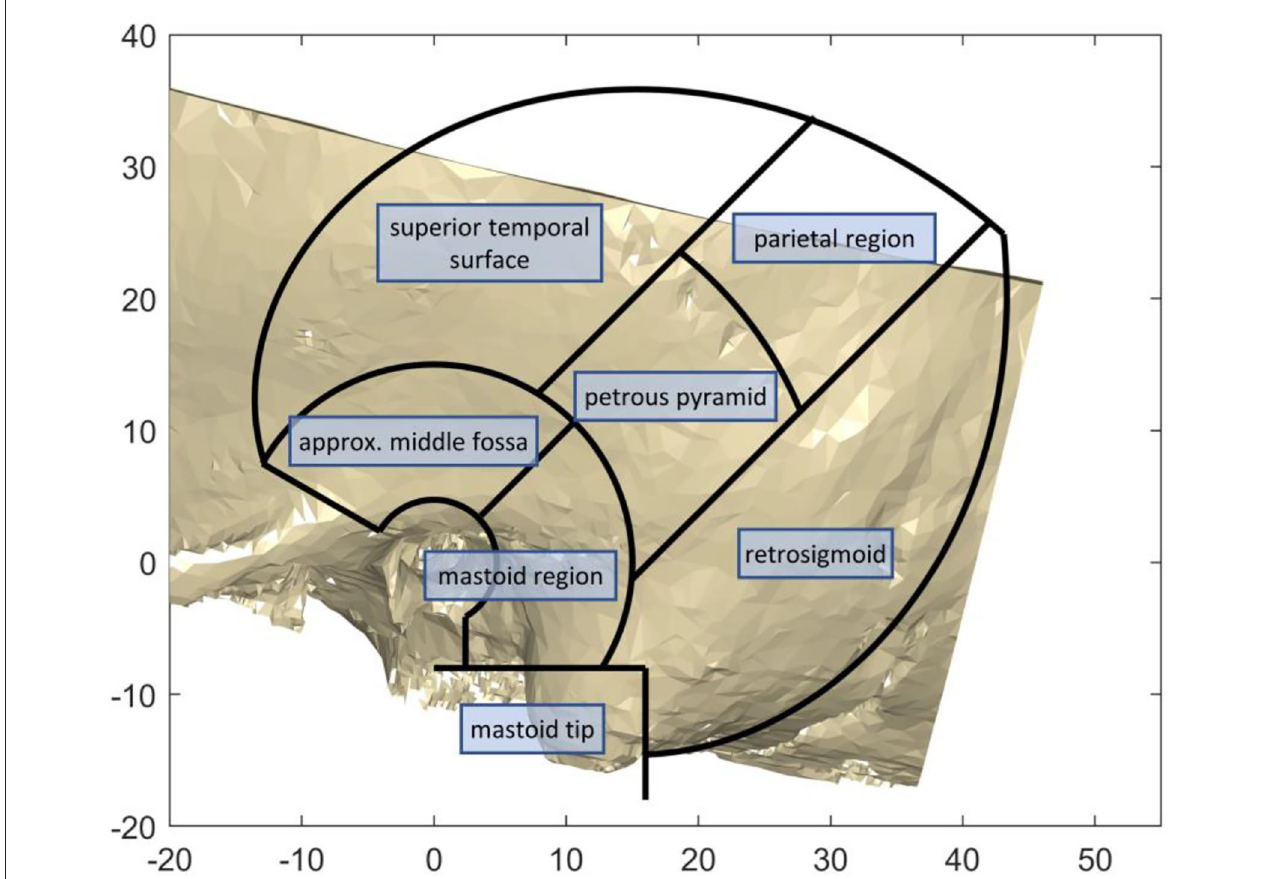
FIGURE 3 | The anatomical regions of the temporal bone used for the analysis.